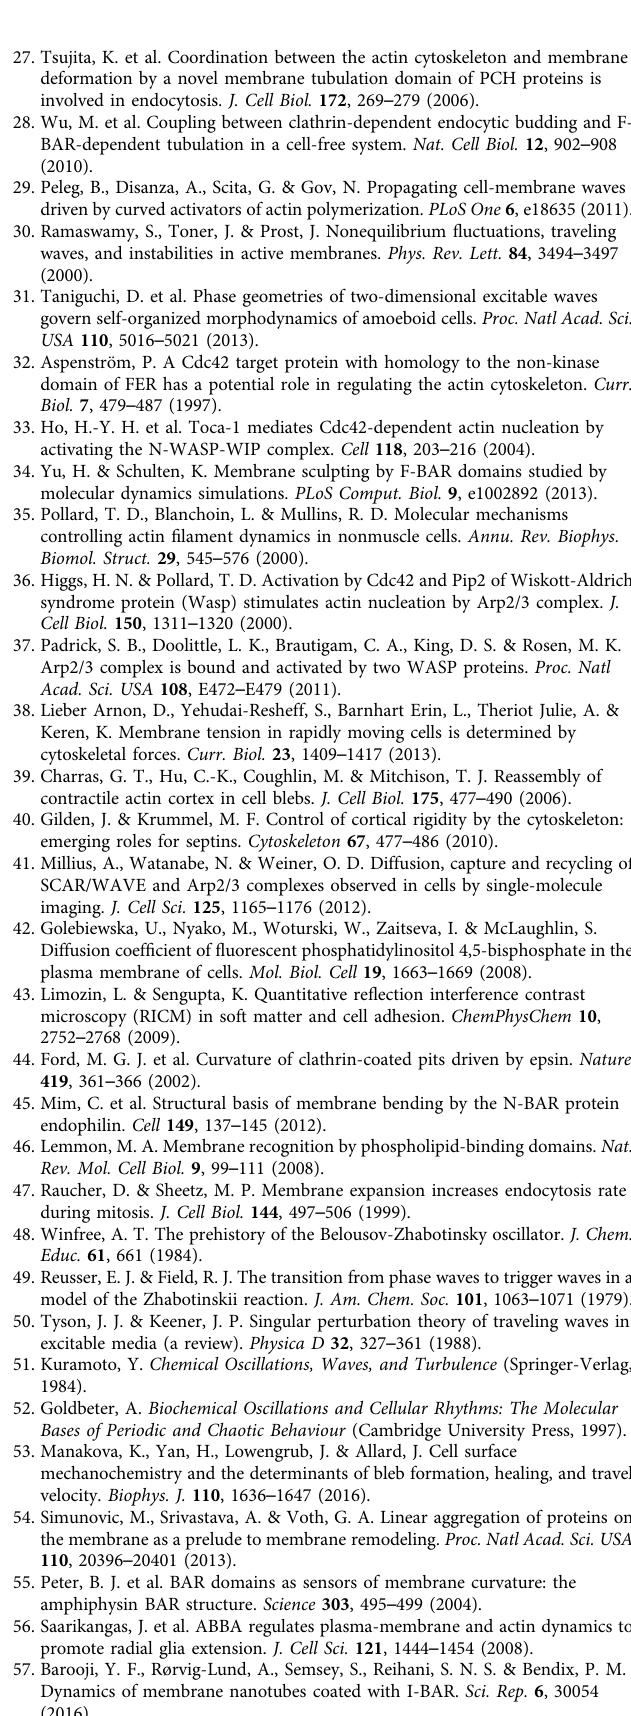
Theoretical model analysis . Detailed theoretical model formulation and analysis are provided in Supplementary Notes 1 – 3, and Supplementary Tables 1 – 3. Data availability . Data supporting the fi ndings of this study are available within the article (and its Supplementary Information fi le) and from the corresponding authors on reasonable